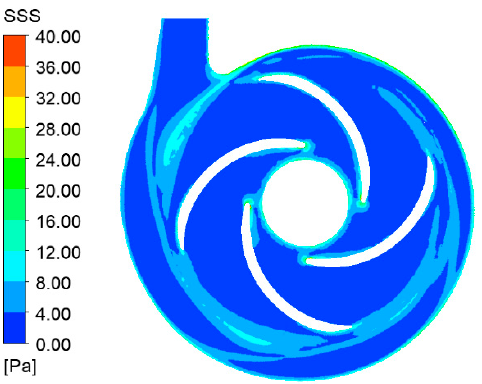
Figure 9. Simulated distribution of scalar shear stress (SSS) on the mid-height plane of test pump No. 10 at the original design point ( Q 0 = 5.0 L/min, n = 2500 r/min). No. 10 at the original design point ( Q 0 = 5.0 L/min, n = 2500 r/min).